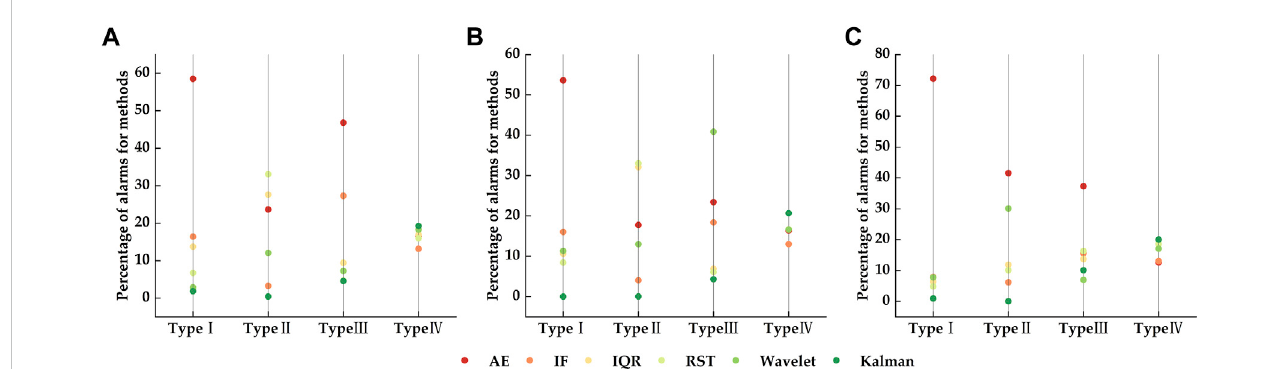
FIGURE 5 The result of type alarms. (A – C) represent the ratio of each type of alert generated by different methods to the overall training (A) , test (B) and validation (C) steps. (A – C) display relatively consistent features; warm and cold color scatter represent the proportion of alerts of that type generated by the method, with warm colors representing the proportion and cold colors the